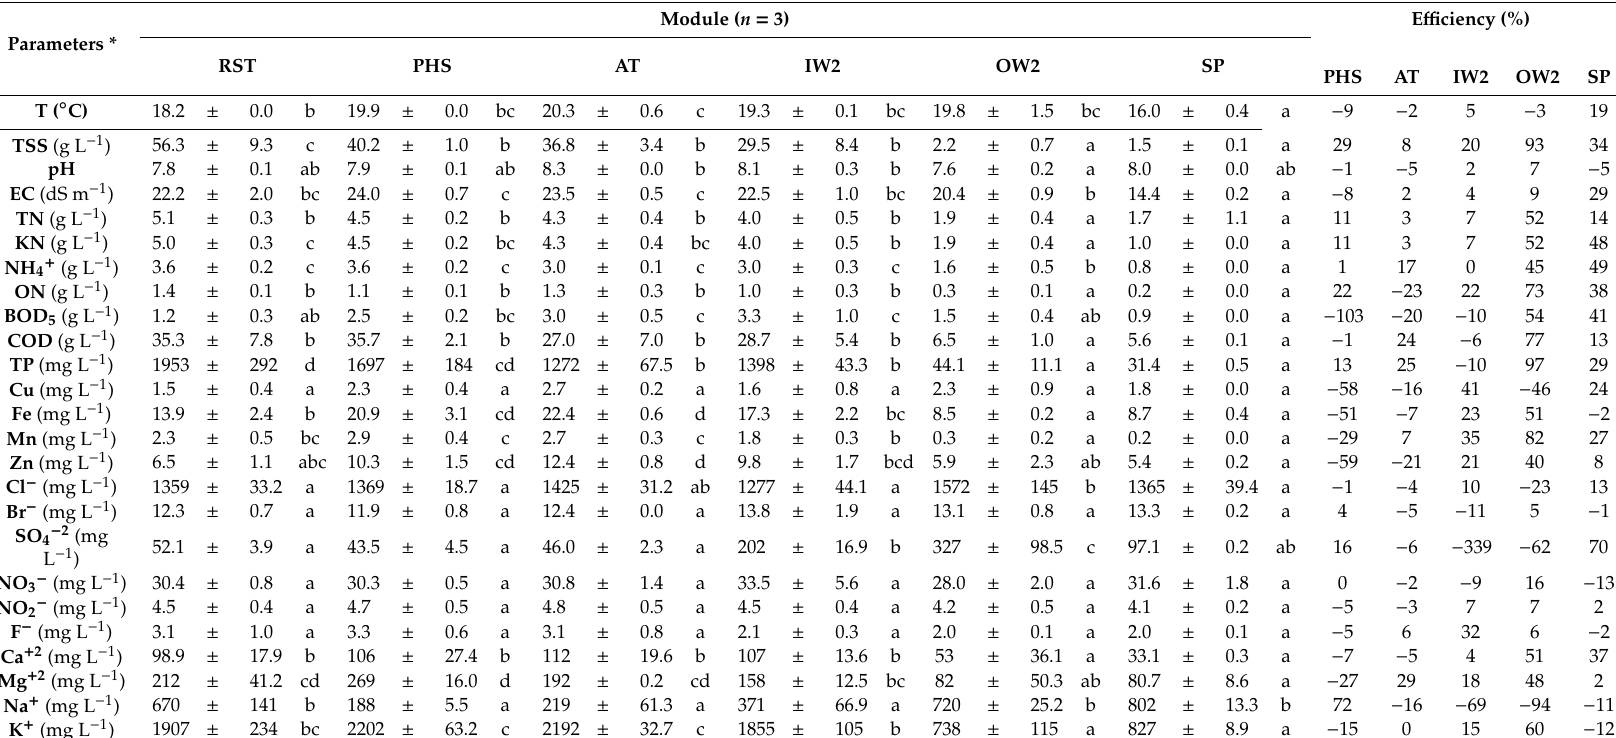
Table 2. Mean and standard deviation values, e ffi ciencies of each module for planted cell (W2). E ffi ciency is referred to a previous